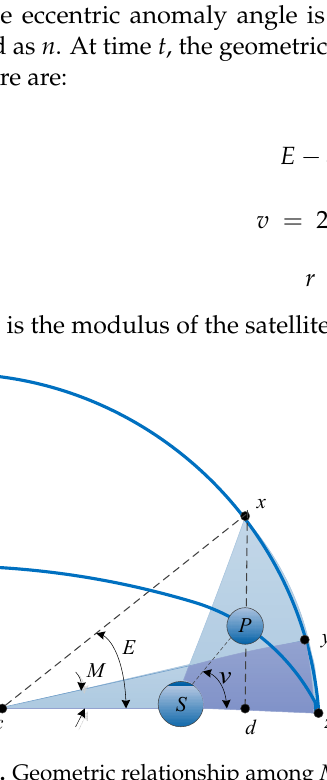
Figure 5. Geometric relationship among M , v and E .